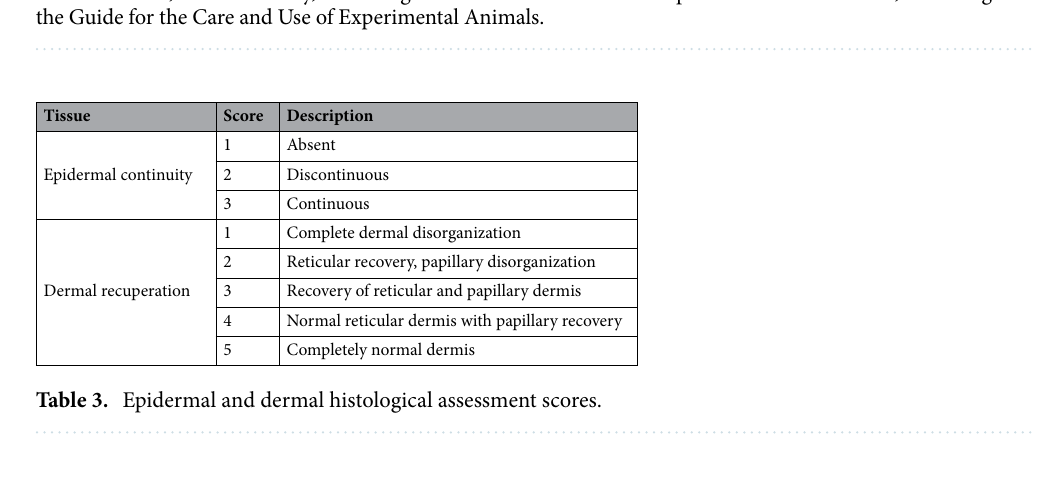
Figure 9. Biopsy location. The wounds were divided into four parts with two imaginary lines. Biopsies were taken clockwise from the center of each part (according to day 0) on days 0, 7, 14, and 21. Thus, each animal was its own control, and in this way, we managed to reduce the number of experimental animals used, according to the Guide for the Care and Use of Experimental Animals.